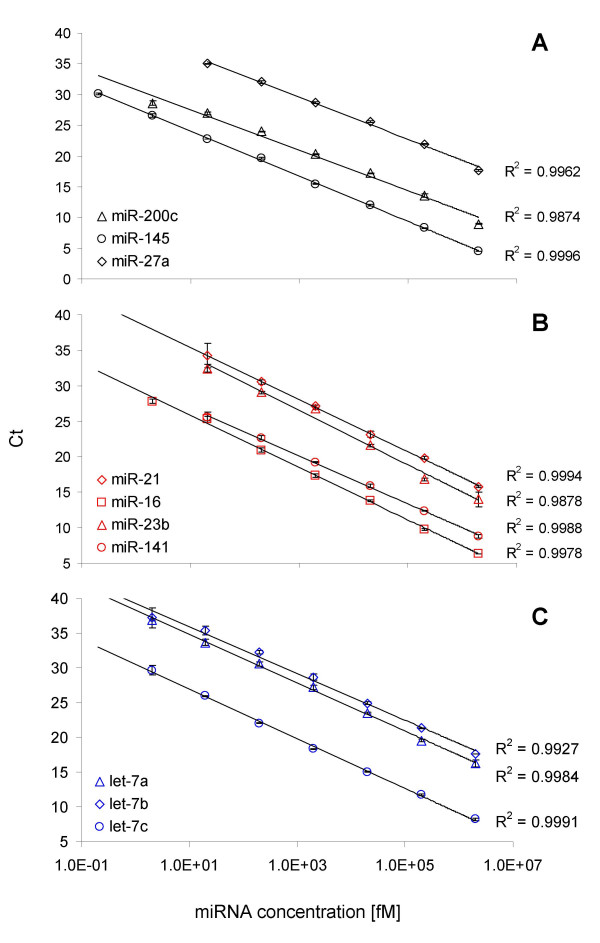
Dynamic range and sensitivity limit of ten miR-Q assays. Each value represents the mean (± SD) of three measurements. They showed dynamic ranges between 6 and 8 orders of magnitude, comprising a sensitivity of up to 0.2 fM synthetic miRNA. A) Dynamic ranges of miR-Q assays: miR-200c (black triangles), miR-145 (black circles), and miR-27a (black rhombi). B) Dynamic ranges of miR-Q assays: miR-21 (red rhombi), miR-16 (red squares), miR-23b (red triangles), and miR-141 (red circles). C) Dynamic ranges of miR-Q assays: let-7a (blue triangles), let-7b (blue rhombi), and let-7c (blue circles).